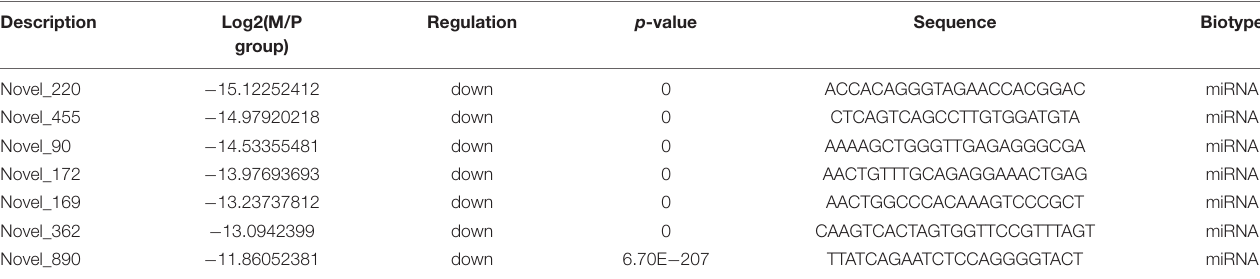
TABLE 4 | The highest expression of DEmiRNAs in M group vs. P group of RNA-Seq.